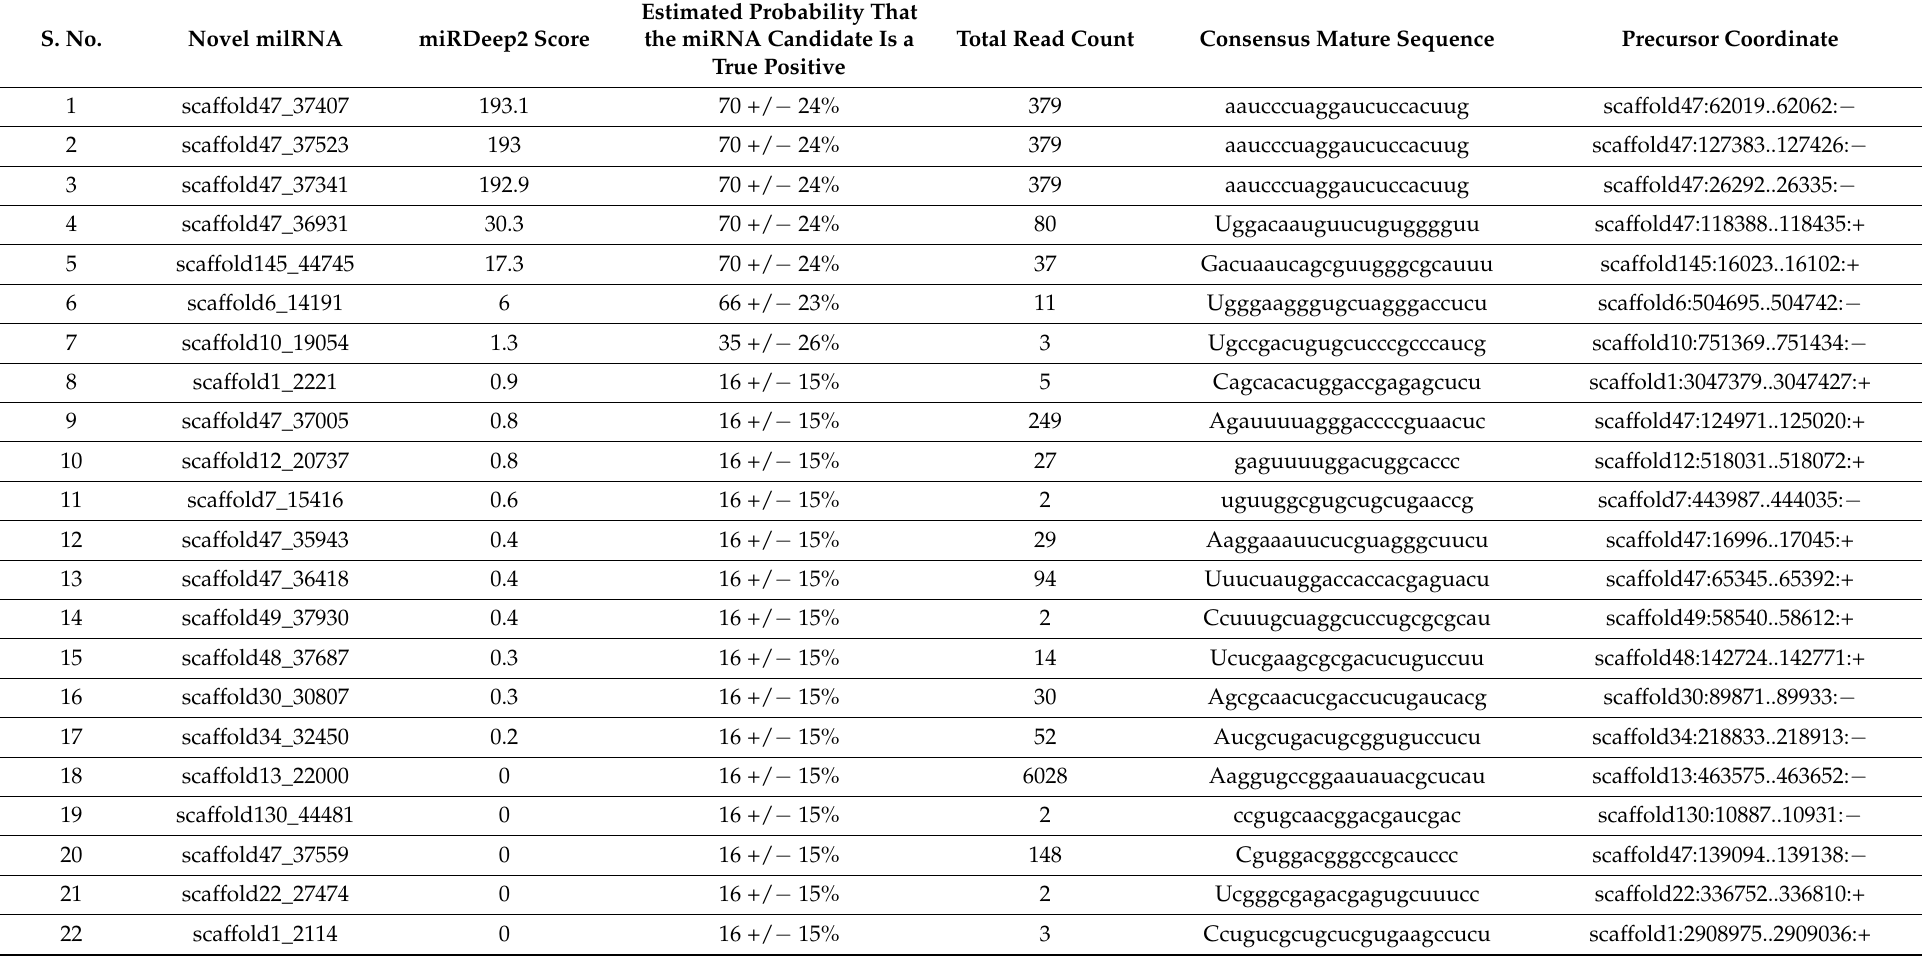
Table 1. Novel milRNAs predicted from small RNA sequence data of Rhizoctonia solani AG1-1A Wgl-2